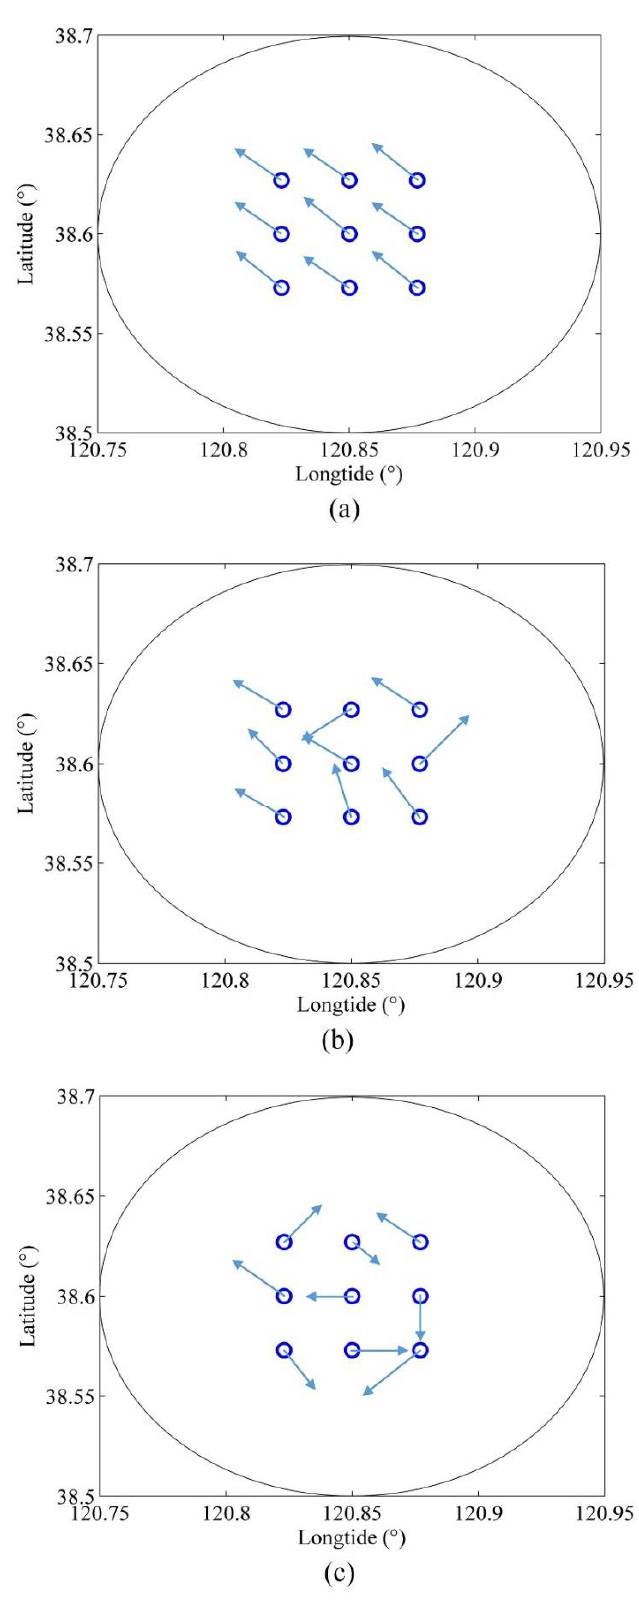
Figure 14. The scenarios for the expanded case study ( a ) Scenario 1; ( b ) Scenario 2; ( c ) Scenario 3. It can be found that the complexity on ship position in Table 9 can react to the change of compactness, which becomes higher compared to the results in Table 2. However,